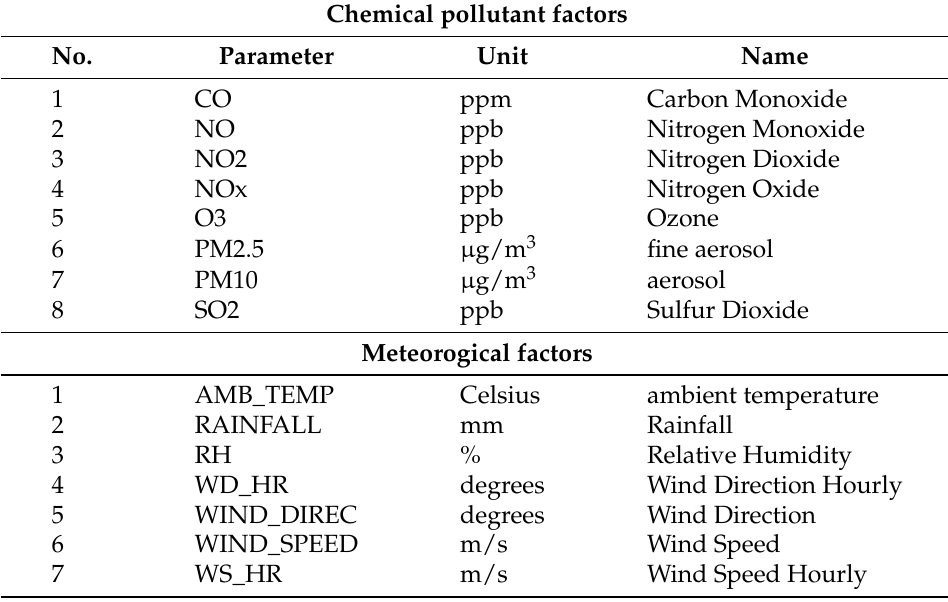
Table 4. Dataset Air Pollutant Parameters.